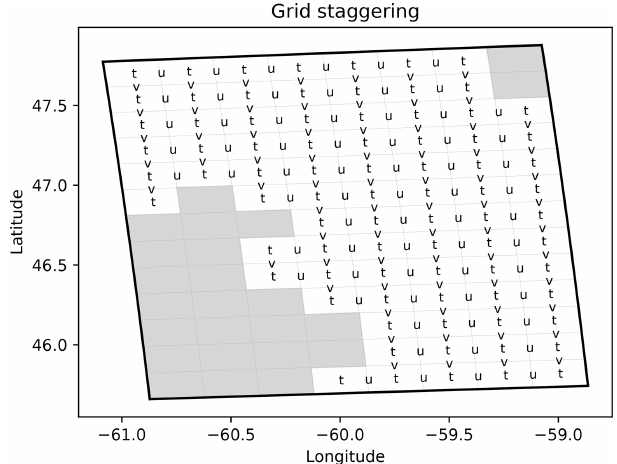
Figure 2. Grid point locations (letters) and land region (grey re- gion) for a sample horizontal plane in the Gulf of Saint Lawrence, between Nova Scotia and New Brunswick. The horizontal velocities ( u and v ) are staggered with respect to temperature and salinity ( t ), and the edge of the land area is coincident with the lines between velocity-point